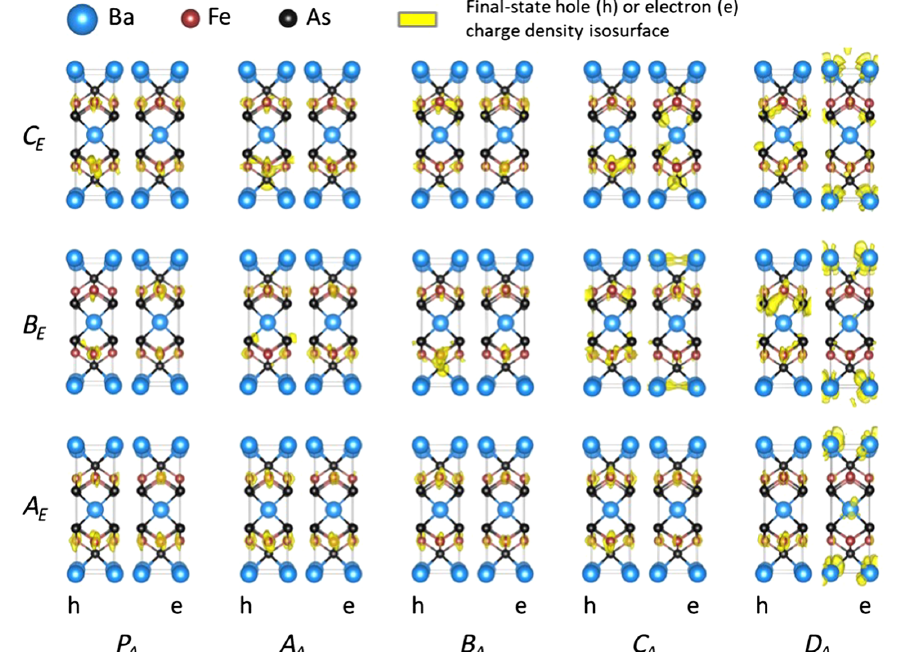
FIG. 5. BSE-calculated isosurface plots for the charge density of the hole ( h ) and electron ( e ) components of the RIXS final state exciton wave function for different combinations of absorption ( P Figs. 1(b) and 2(b), respectively ( P combination of absorption and emission features, the left (right) isosurface plot corresponds to the hole (electron) component of the final-state exciton wave